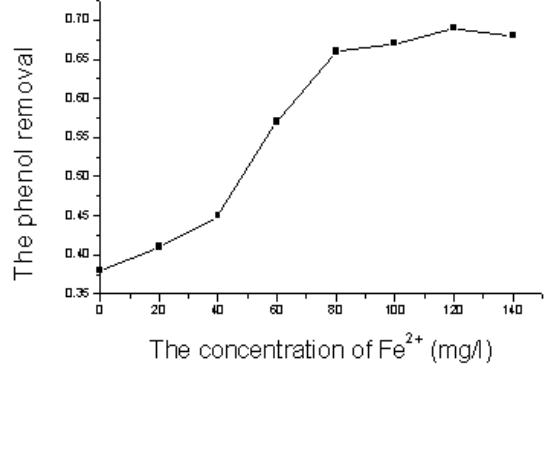
Fig. 5 The catalysis of Fe 2+